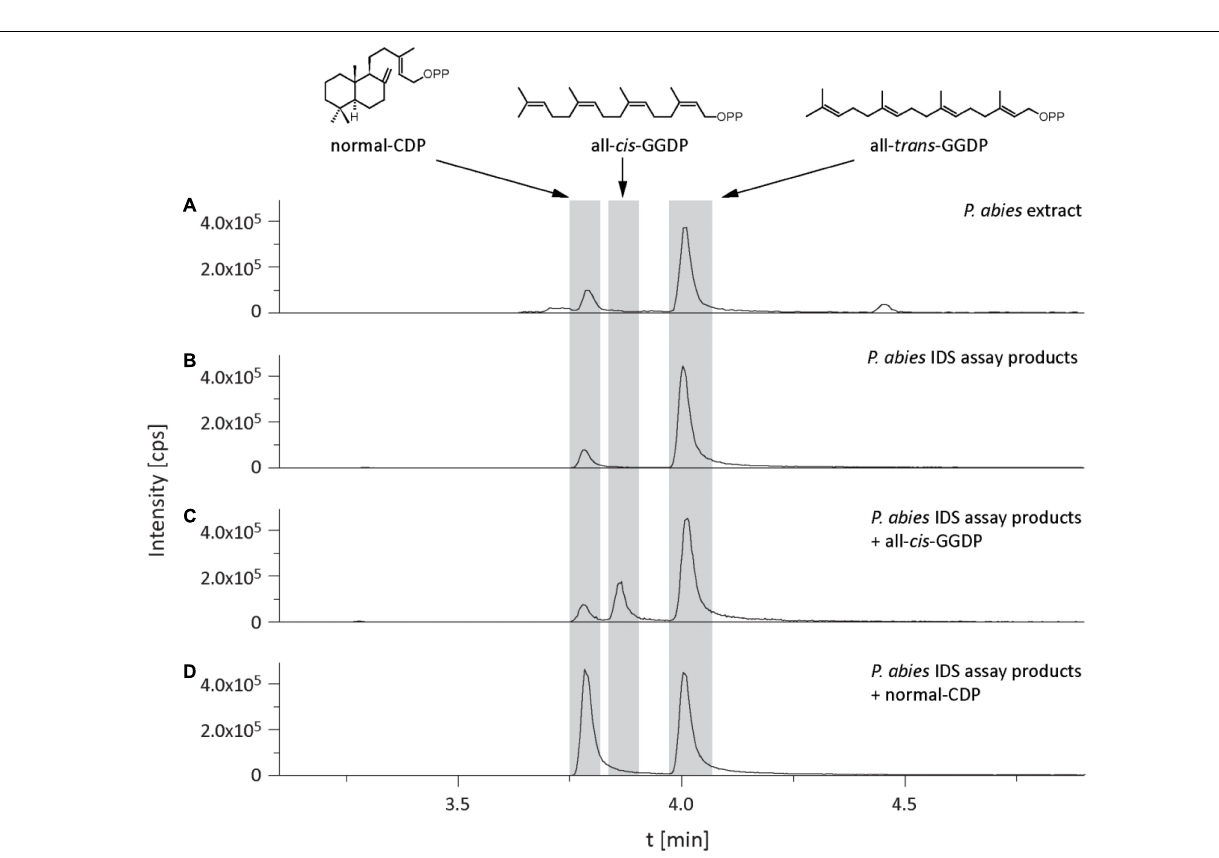
Frontiers in Plant Science |